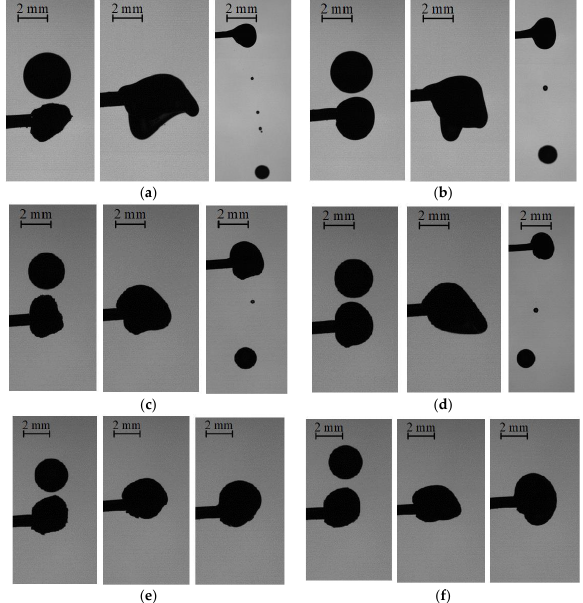
Figure 5. Images of collisions of used motor oil droplets with carbonaceous particles of coking coal filter cake at varying droplet sizes: ( a , c , e ) — dry particles; ( b , d , f ) — particles containing water on the surface; ( a , b ) — R d = 1.45 mm; ( c , d ) — R d = 1.3 mm; ( e , f ) — R d = 1.1 mm. filter cake at varying droplet sizes: ( a , c , e )—dry particles; ( b , d , f )—particles containing water on the surface; ( a , b )— R d = 1.45 mm; ( c , d )— R d = 1.3 mm; ( e , f )— R d = 1.1 mm.